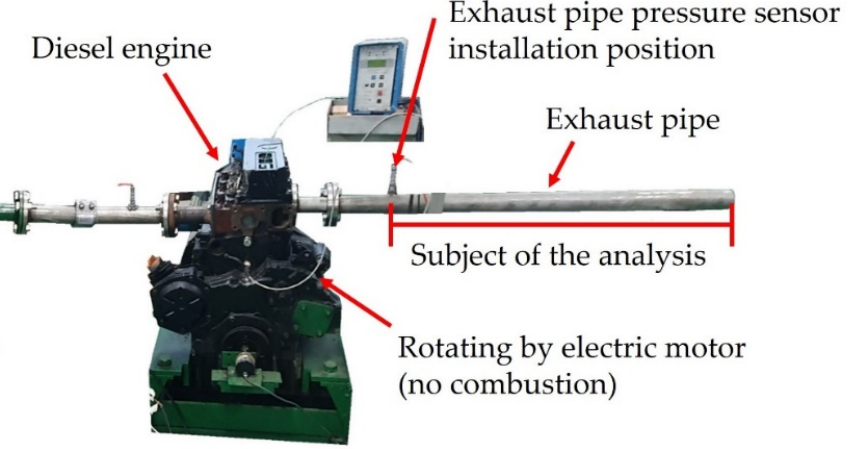
Figure 4. Configuration of the experimental device for validation.